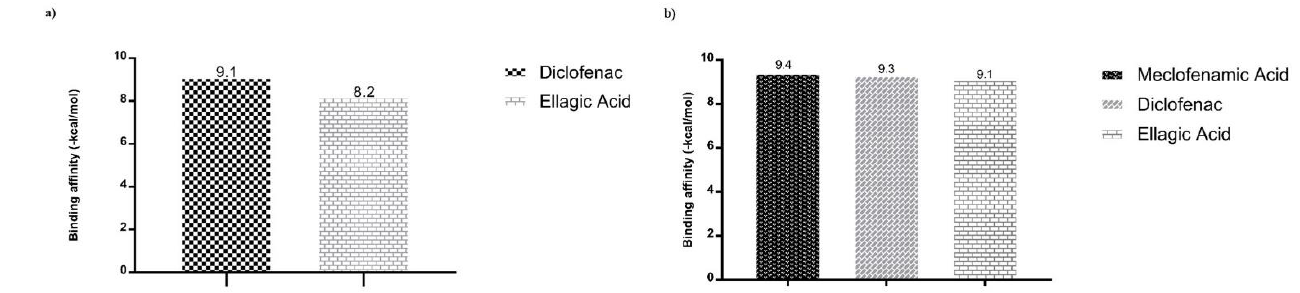
Figure 3. Binding affinity values of the ligands with the inflammation targets obtained by molecular docking via Dockthor: ( a ) with the murine COX2 (PDB ID 1PXX); and ( b ) with the human COX2 (PDB ID 5KIQ).